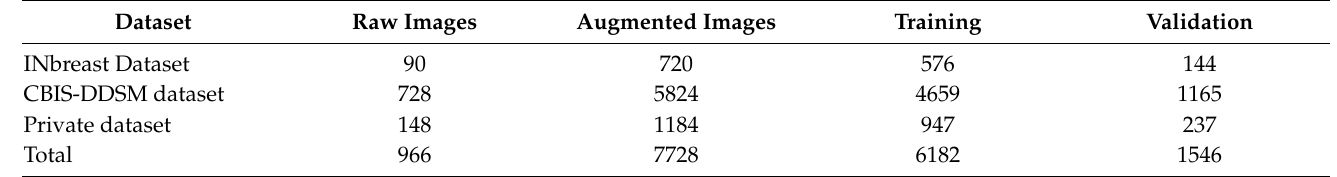
Table 2. The number of training and validation samples before and after data